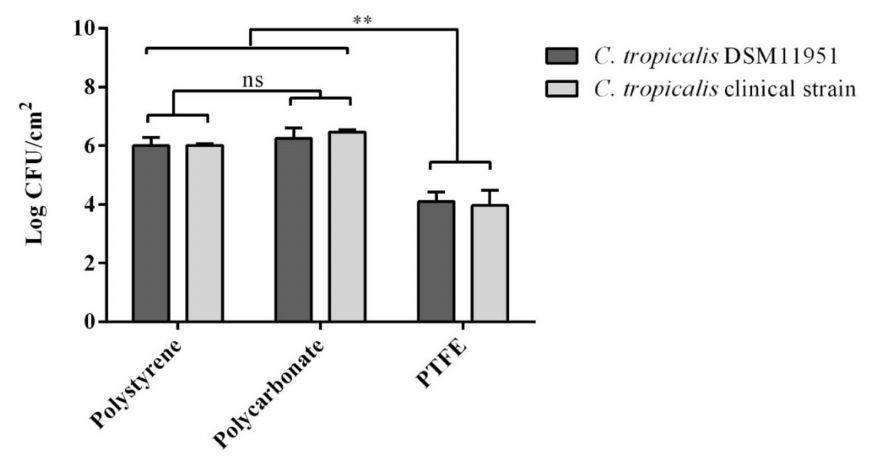
Figure 1. Log fungal density (means and standard deviations) of C. tropicalis DSM 11951 and C. tropicalis clinical isolate for each material evaluated. ns: not significant, ** p value < 0.01